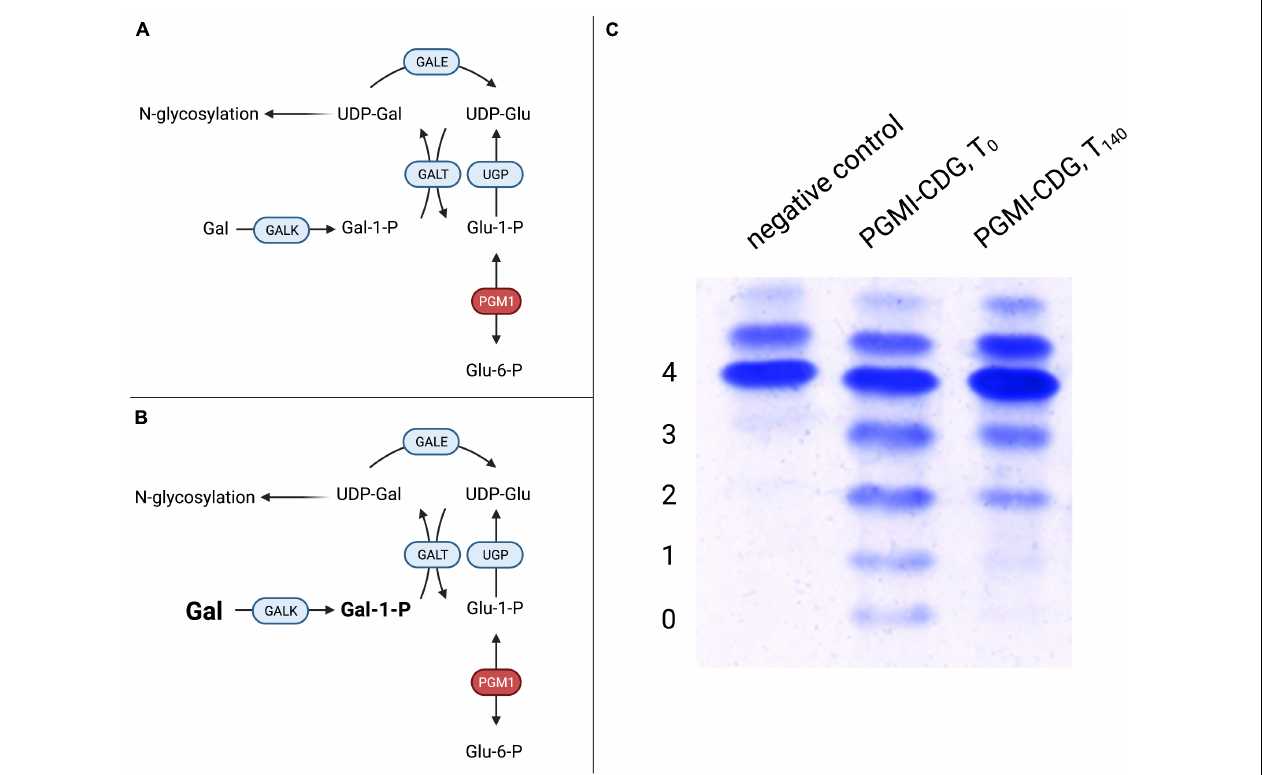
FIGURE 4 | Galactose therapy in PGM1-CDG. (A) A defect in PGM1 hinders conversion of glucose-1-phosphate (Glu-1-P) to glucose-6-phosphate (Glu-6-P), thus impairing hepatic glucose release. Similarly, the reverse reaction in which Glu-6-P is converted to Glu-1-P, which can serve as a substrate for UDP-glucose production by UDP-glucose pyrophosphorylase (UGP) for glycogen synthesis or glycosylation, is impaired. (B) Supplemented galactose is transformed to UDP-galactose (UDP-Gal) by galactose-1-phosphate uridyltransferase (GALT). UDP-Gal can serve both in glycosylation and as a substrate for UDP-galactose epimerase (GALE), supplying UDP-Gal for glycogen metabolism. (C) Transferrin IEF profiles during galactose substitution over 140 days in PGM1-CDG. Compared to controls, PGM1-CDG shows a characteristic, “ladder-like” pattern in IEF (PGM1-CDG, T 0 ). Following 20 weeks of galactose substitution at a dose of 1 g/kg bodyweight/day, significant improvement with reduced abnormal transferrin isoforms was observed (PGM1-CDG, T 140 ) (4 – tetrasialo-transferrin, 3 – trisialo-transferrin, 2 – disialo-transferrin, 1 – monosialo-transferrin, 0 –